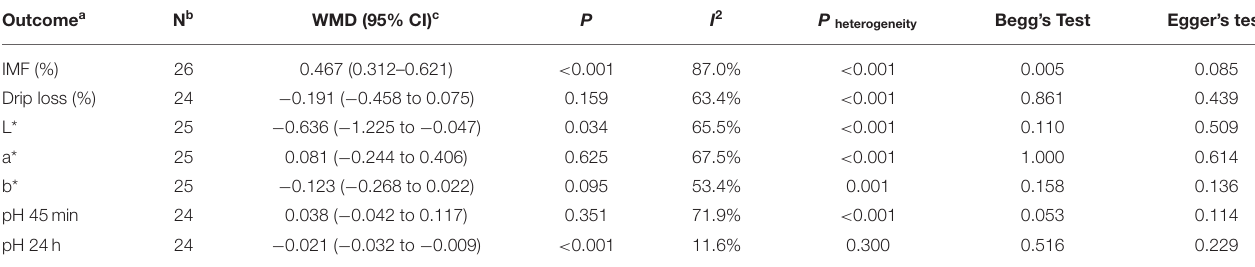
TABLE 3 | The summary of meta-analysis and publication bias analysis of the included studies. Outcome